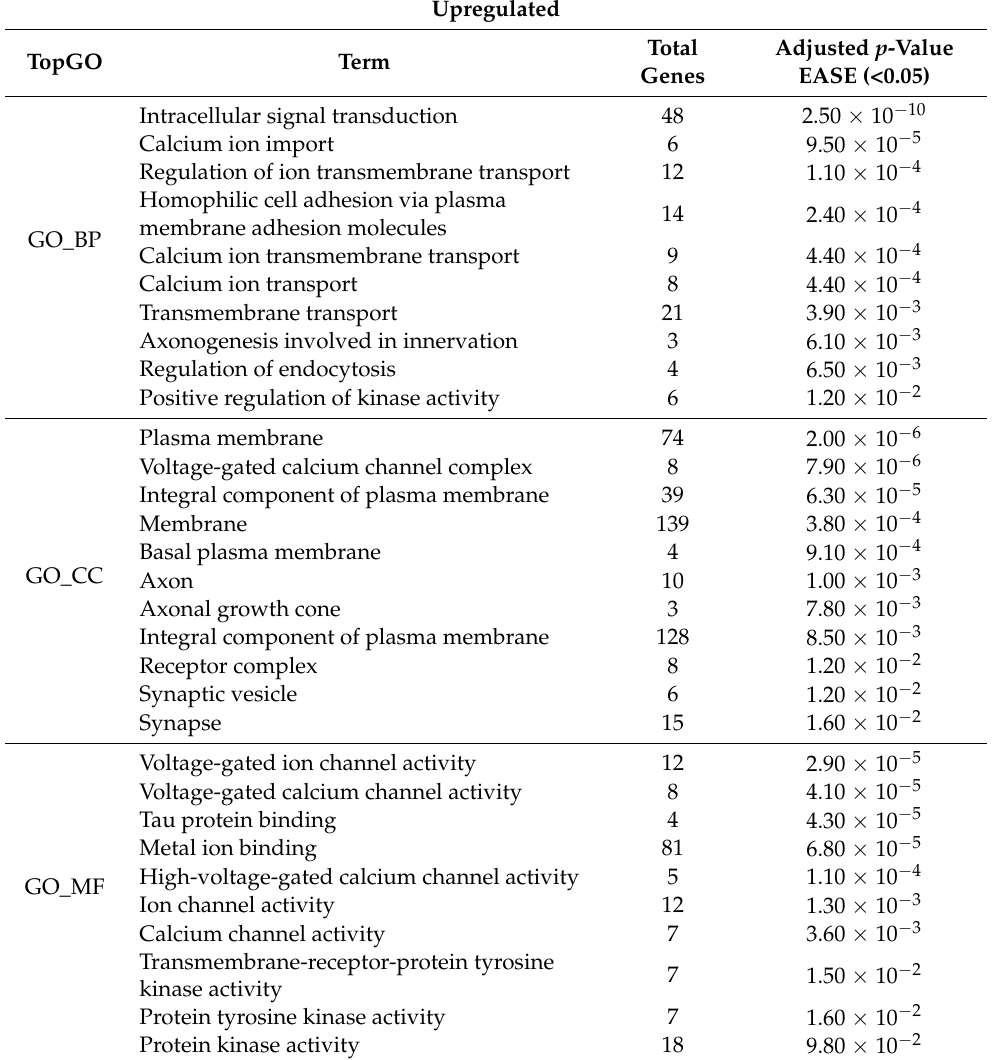
Table 1. Top 10 upregulated gene sets enriched based on gene ontology (GO) term with adjusted p -value EASE